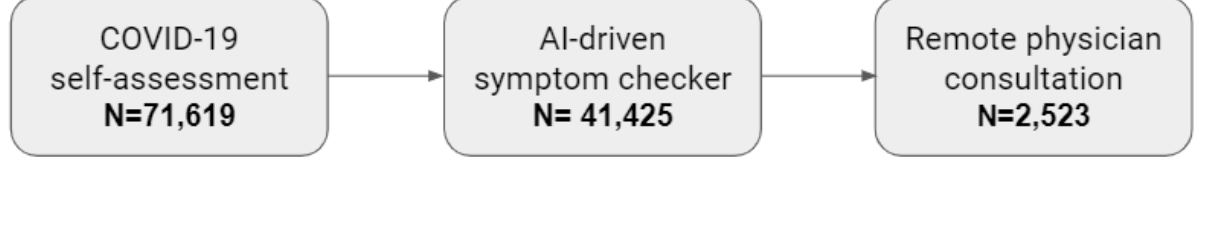
Table 1. Characteristics of the cohort of COVID-19 self-assessment users